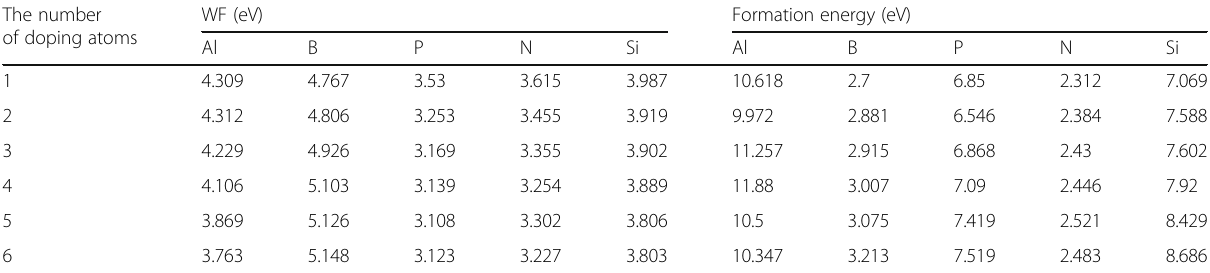
Table 2 The WF and formation energy of the 4 × 4 graphene doped with the atoms of Al, B, P, N and Si, respectively The number WF (eV) Formation energy of doping atoms